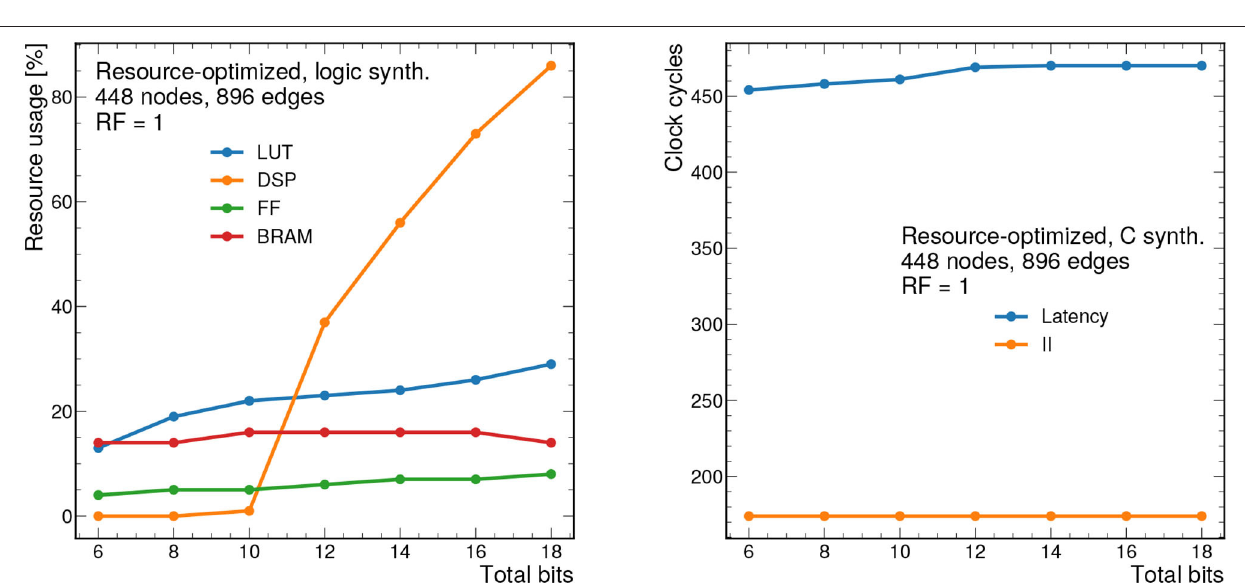
2 n nodes , as is empirically observed for the 2GeV =